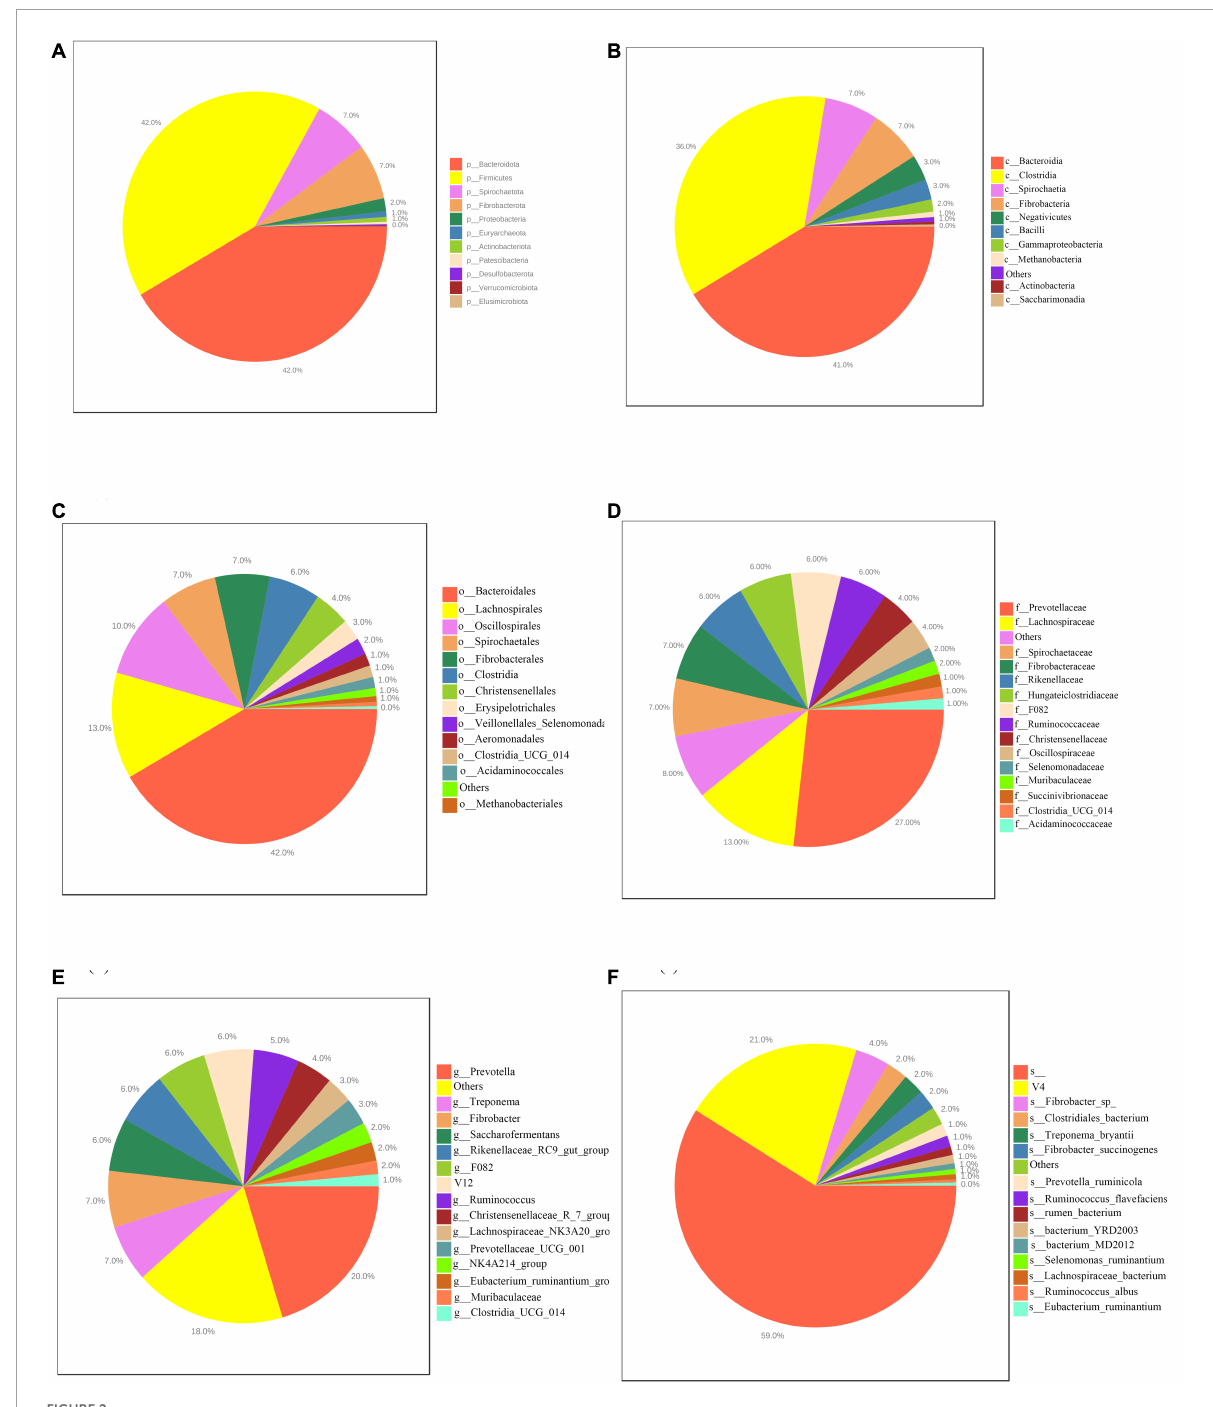
FIGURE2 Pie charts showing the average relative abundance of the dominant bacterial phylum (A) , class (B) , order (C) , family (D) , genera (E) and species (F) in the rumen of Hu sheep.